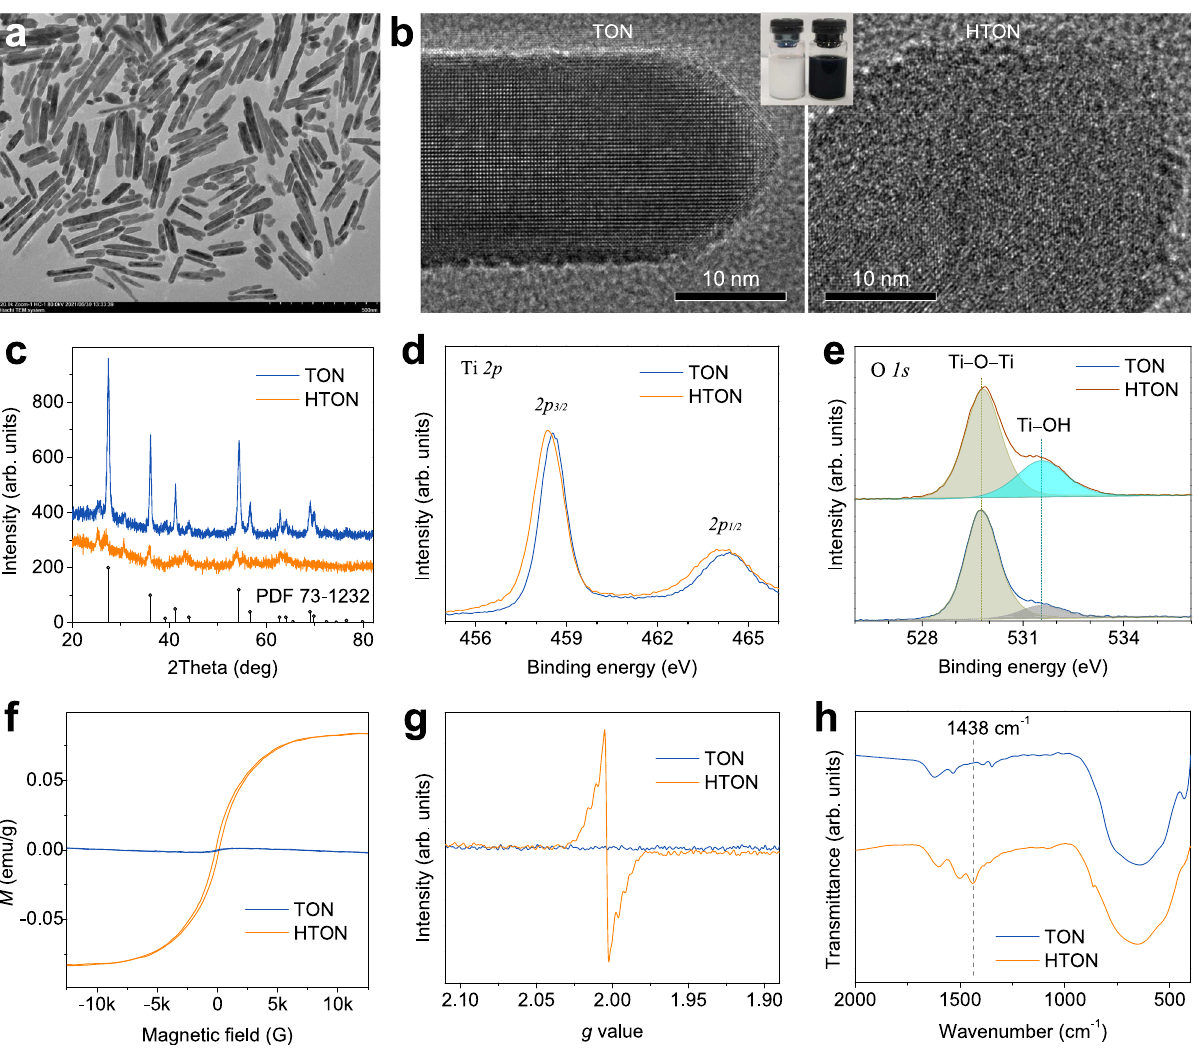
Fig.2|Morphology,compositionandsizecharacterizationoftheHTONnanocatalyst. TEMimageofHTON( a ),HR-TEMimages( b ),XRD( c ),XPSpatterns( d , e ),VSM pattern ( f ), EPR spectra ( g ), and FTIR spectra ( h ) of TON and HTON. The experiments for a , b were repeated three times independently with similar